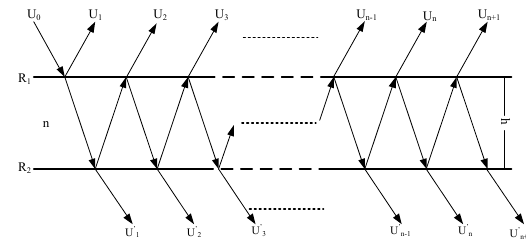
Figure 1 Principle of etalon